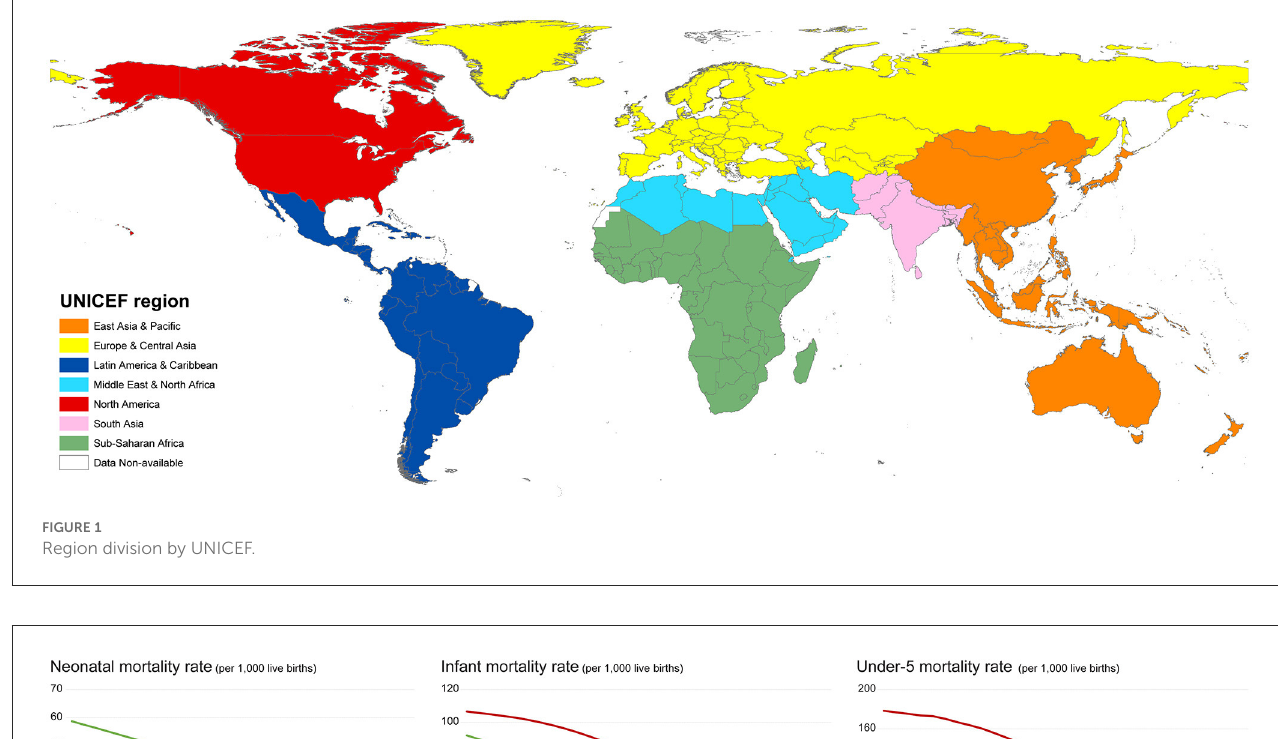
FIGURE1 Region division by UNICEF.